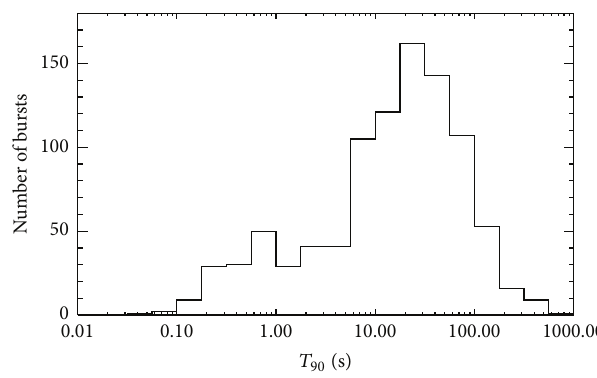
Figure 2: Distribution of GRB durations ( 𝑇 90 ) of 953 bursts in the Fermi -GBM (50 – 300 keV energy range). Taken from the 2nd Fermi catalog, [23]. 159 (17%) of the bursts are “short.”